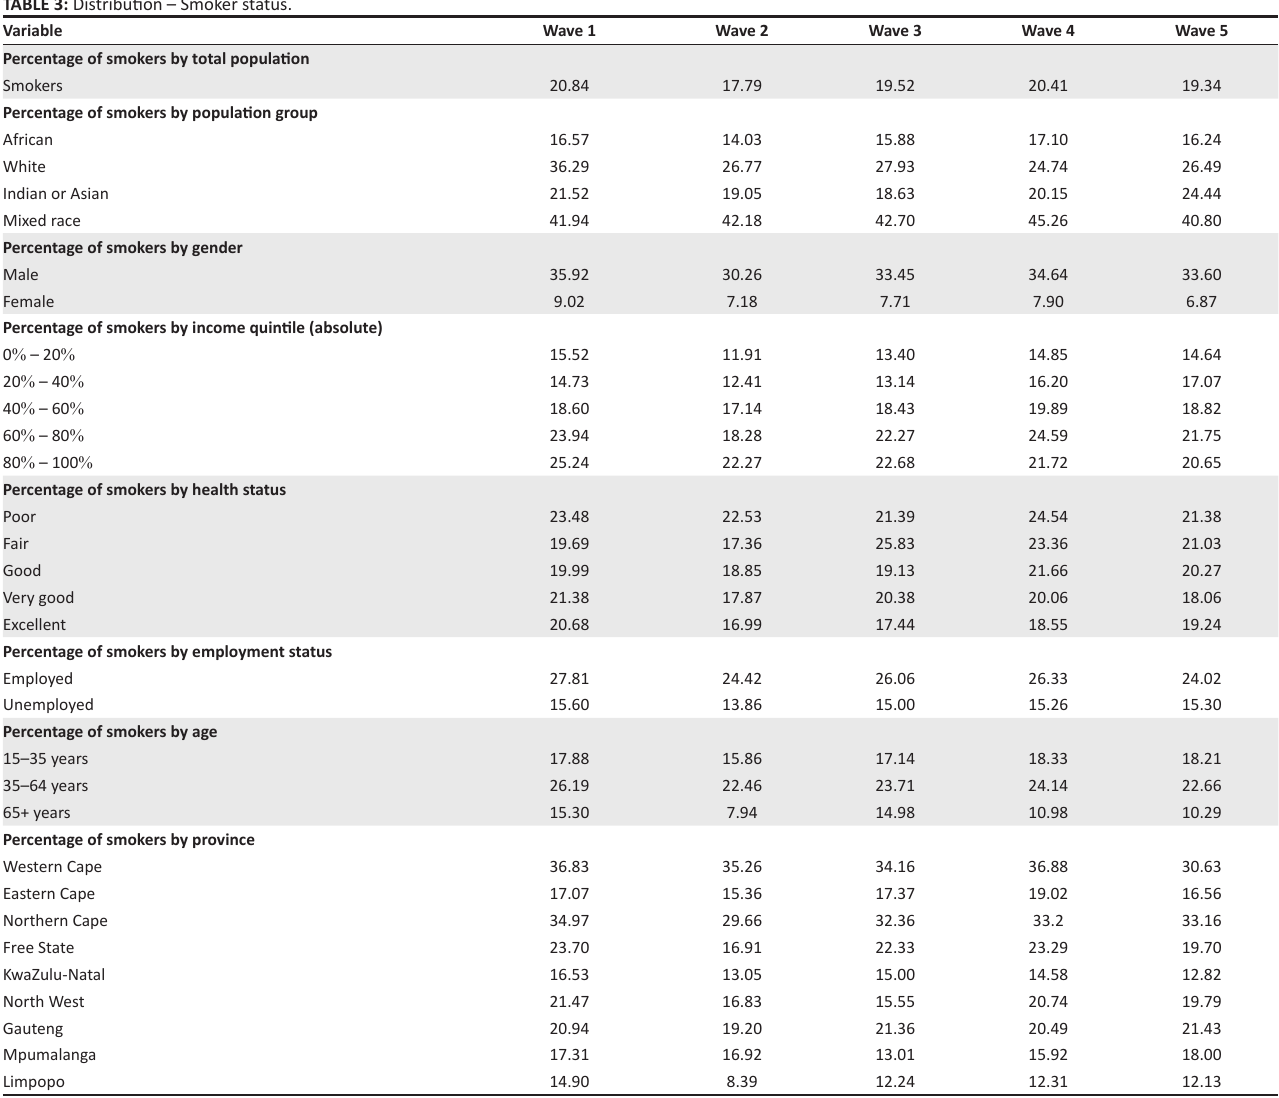
TABLE 3: Distribution – Smoker status.